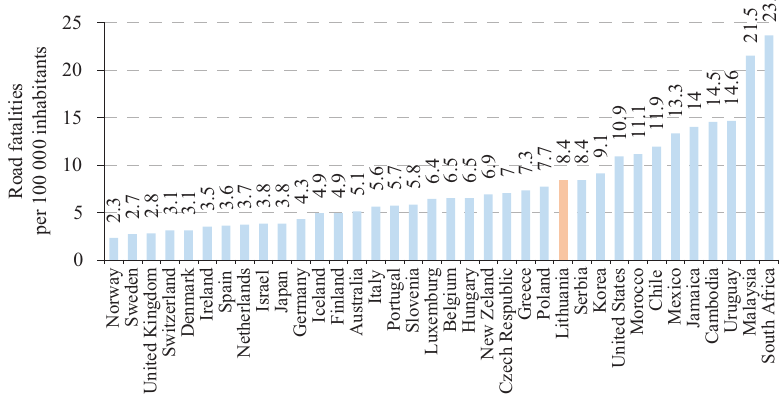
Figure 1. Road fatalities per 100 000 inhabitants in 2015 (Janstrup,